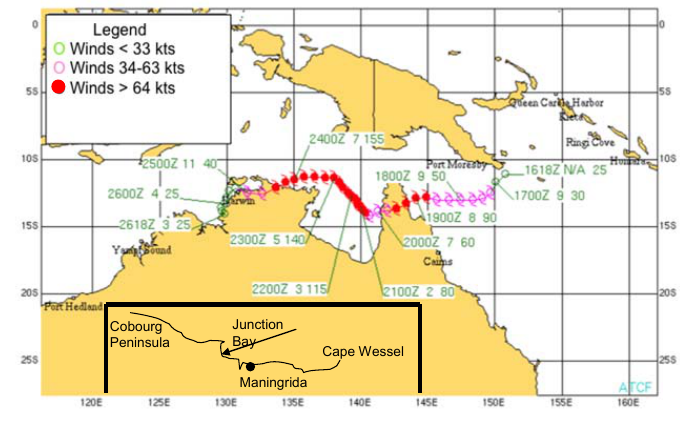
Figure 1. Track of Cyclone Monica (courtesy JTWC). Inset at bottom of map (added by author) provides a simplified view of the Northern Territory, Australia area where Cyclone Monica made landfall (track show as